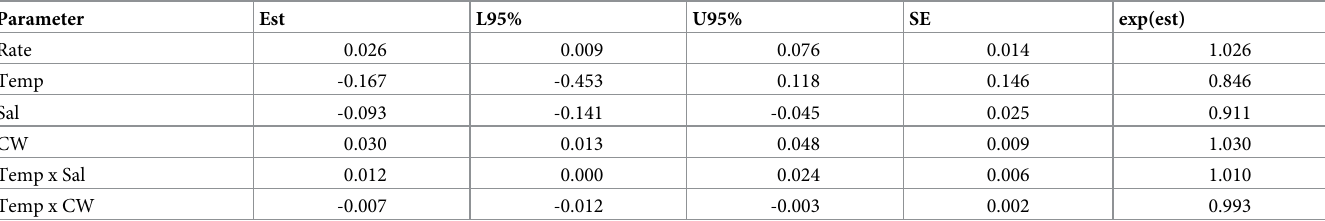
Table 3. Parameter estimates from the best AFT model using all available data, including crabs from Bauer and Miller [52]. Parameter